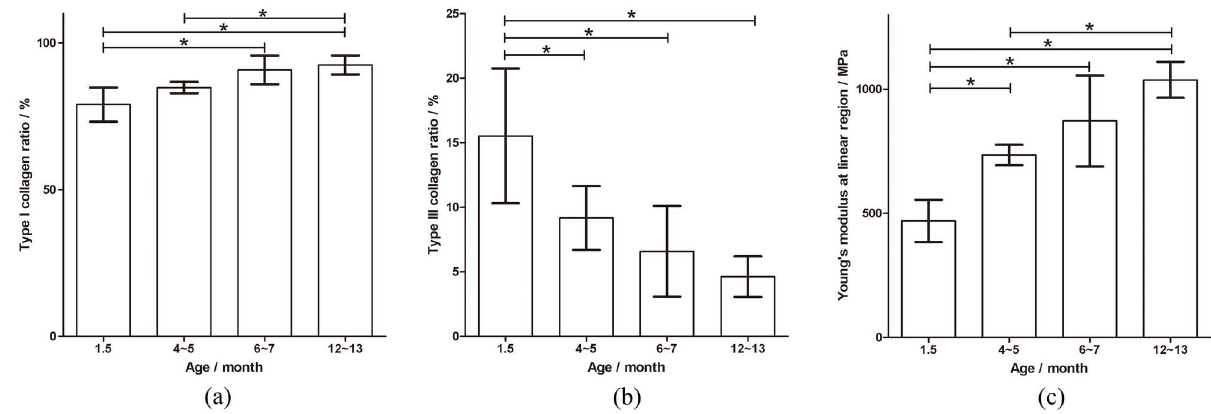
Figure 5. Comparisons of the ratio of type I collagen (a), the ratio of type III collagen (b), and the Young’s modulus in the linear region of the stress-strain curve (c) between the different age groups. During the maturation of ligaments (i.e., from the 1.5-month-old group to the 12- to 13-month-old group), the ratio of type I collagen increased while the ratio of type III collagen decreased. Significant differences were found in the ratio of type I collagen between the 1.5-month-old group and the 6- to 7-month-old group, between the 1.5-month-old group and the 12- to 13-month-old group, and between the 4- to 5-month-old group and the 12- to 13-month-old group (P , 0.05). The ratio of type III collagen in the 1.5-month-old group was significantly higher than that in the other groups (P , 0.05). The Young’s modulus in the linear region changed significantly between the 4- to 5-month-old group and the 12- to 13-month-old group as well as between the 1.5-month-old group and the other three groups (P , 0.05). Mean 6 SD.